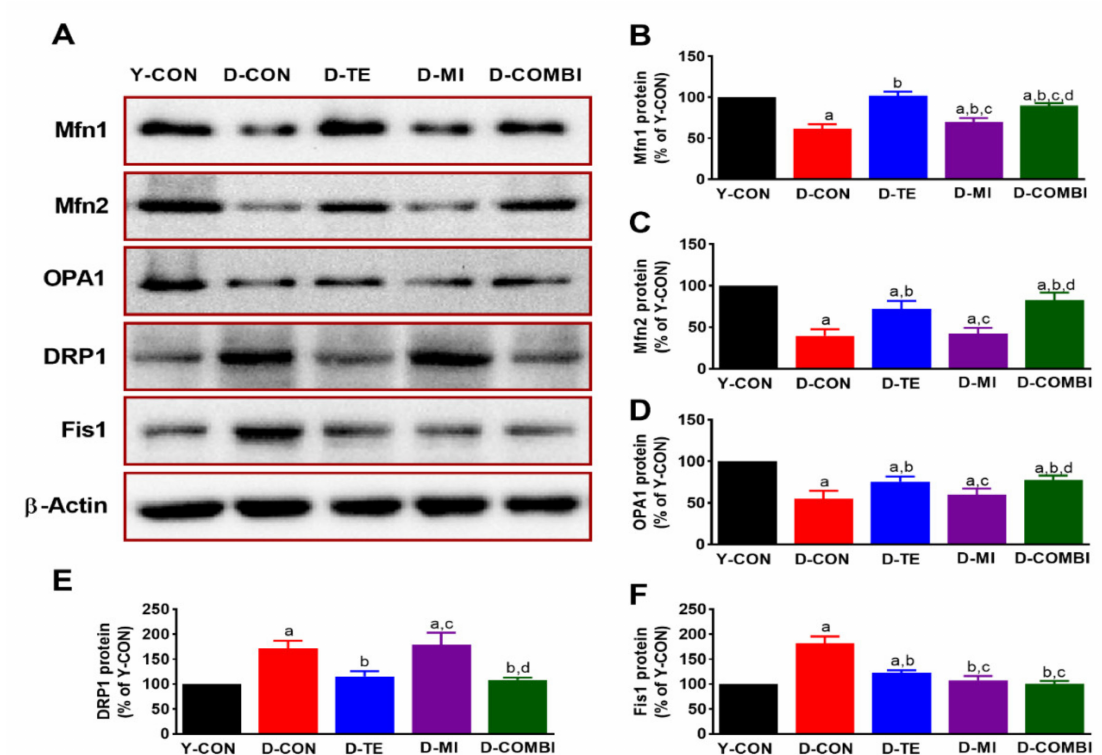
Figure 1. Effect of treadmill exercise and mitoquinone (MitoQ) on the expression of mitochondrial dynamics related proteins in the hippocampus of D-galactose (D-gal) induced aging rats. ( A ) Representative Western blots of mitochondrial fusion- and fission-related proteins. ( B – F ) Densitometric analysis of the Western blot bands normalized to β -Actin. The data shown in the Western blot are means from seven rat brains. β -Actin was probed as an internal control. Bonferroni post hoc test was used after ANOVA. Values are means ± SEM. a Denotes statistical difference from the young control group (Y-CON) group. b Denotes statistical difference from the D-galactose group (D-CON) group. c Denotes statistical difference from the D-galactose plus treadmill exercise (D-TE) group. d Denotes statistical difference from the D-galactose plus MitoQ (D-MI) group ( p < 0.05). D-COMBI; D-galactose plus TE and MitoQ